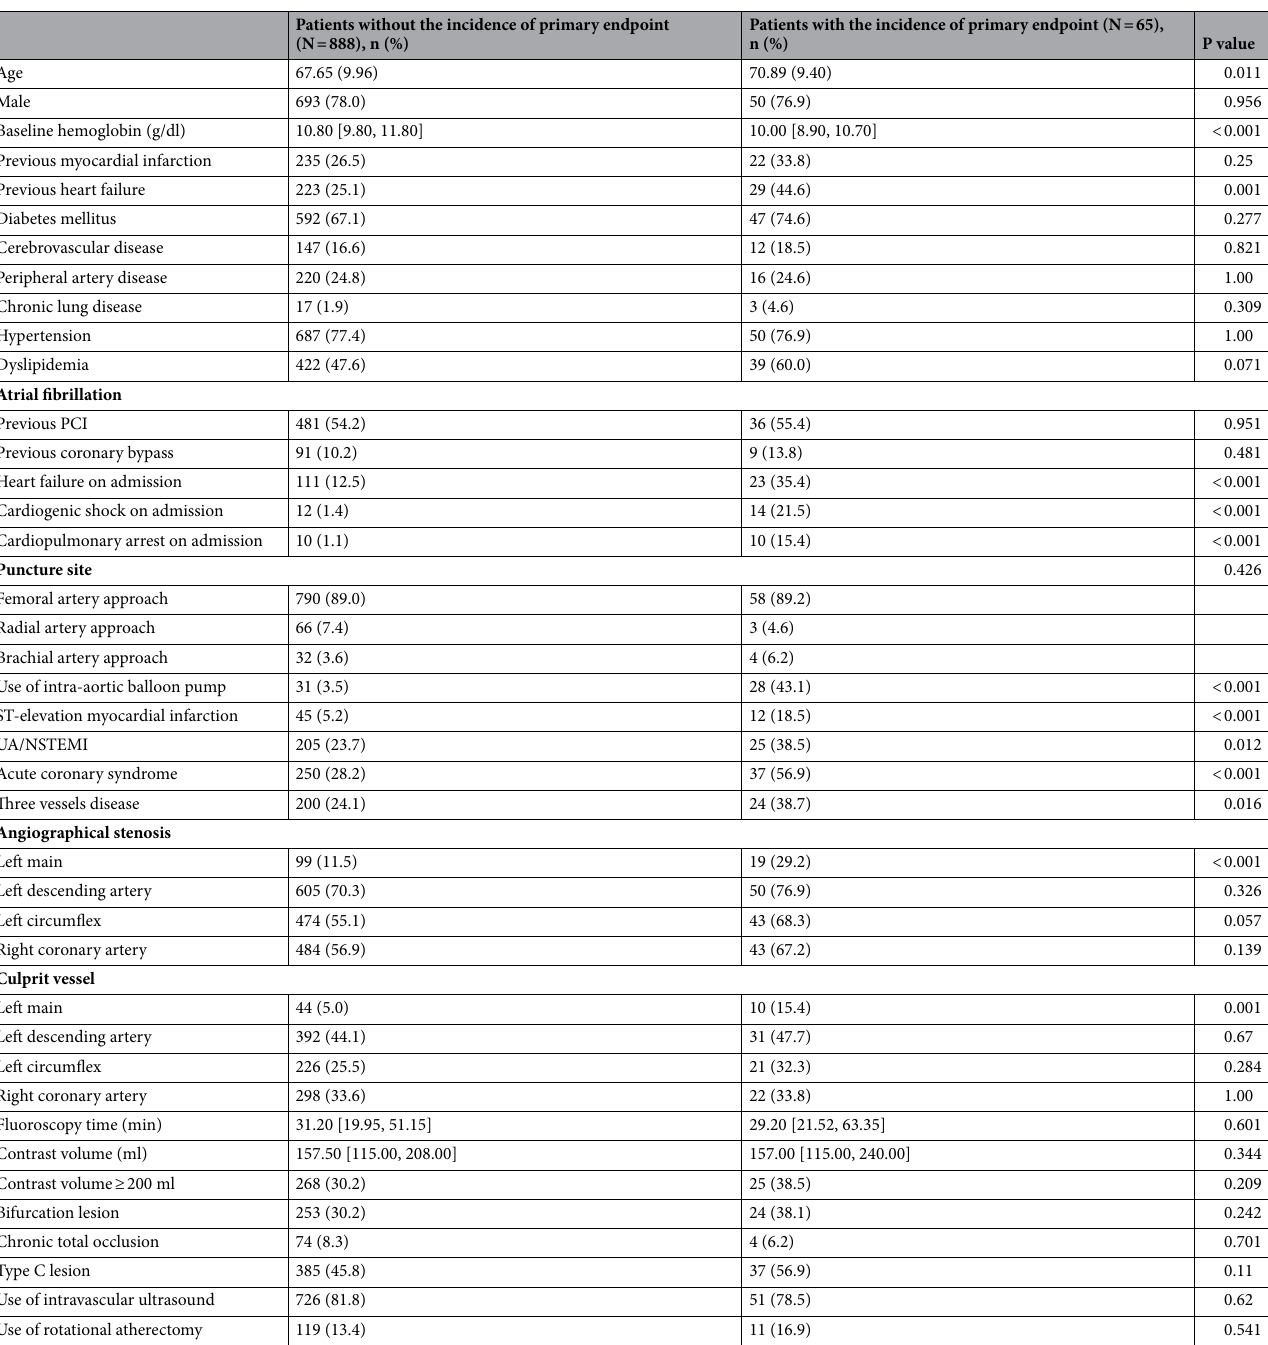
Table 4. Baseline characteristics of all patients; patients with primary endpoint versus those without. PCI percutaneous coronary intervention, UA/NSTEMI unstable angina/non-ST-elevation myocardial infarction. Data are presented as the mean ± standard deviation, number (%), and number [interquartile